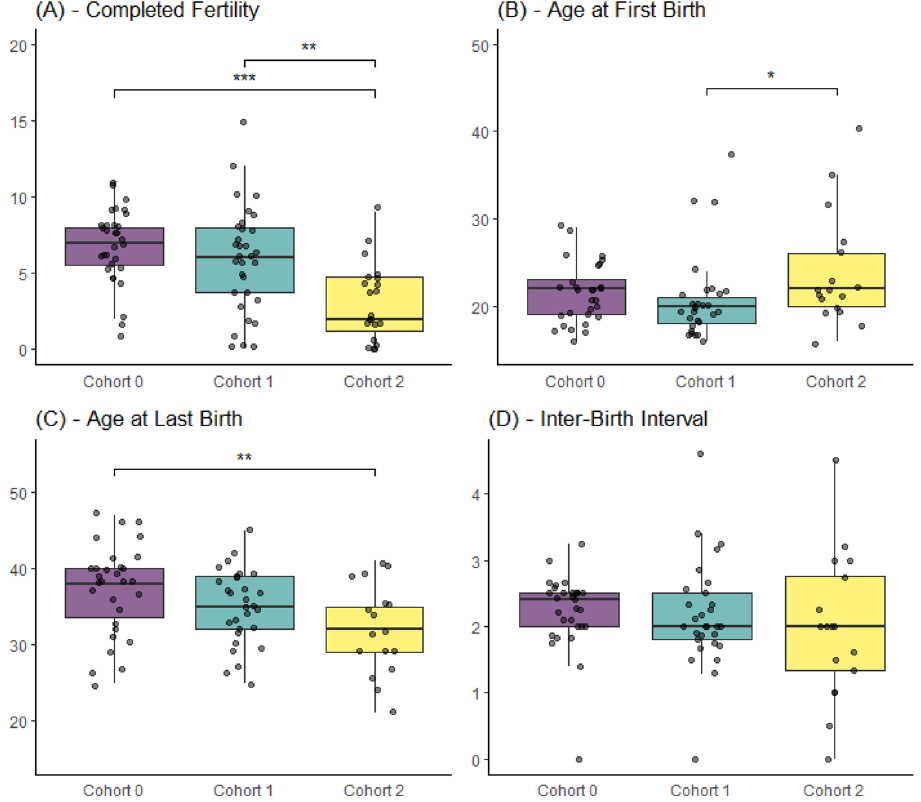
Figure 2. Reproductive traits by cohorts with completed fertility. Pair-wise comparisons shown only for significant results for mean differences, using Wilcox sign test * p < = 0.05; ** p < = 0.01; *** p < =